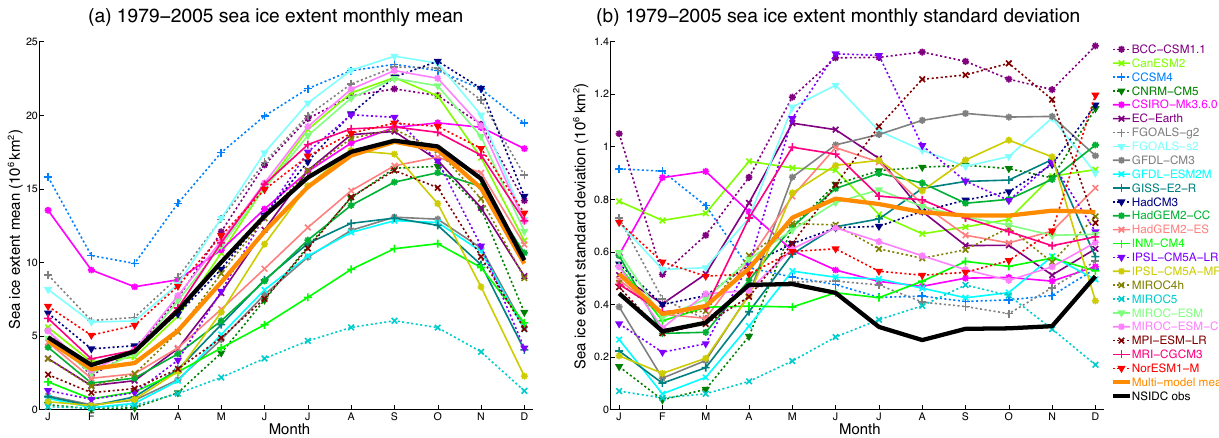
Fig. 2. (a) Monthly mean of Southern Ocean sea ice extent, computed over the period 1979–2005. (b) Standard deviation of detrended Southern Hemisphere sea ice extent, computed over the period 1979–2005 for each month of the year. Colours correspond to the ensemble mean of historical simulations from 24 different models. Dotted lines refer to models that provide both historical and hindcast simulations, but here results are only from historical simulations. Orange bold line is the multi-model mean. Black bold line refers to observations (Cavalieri and Parkinson,